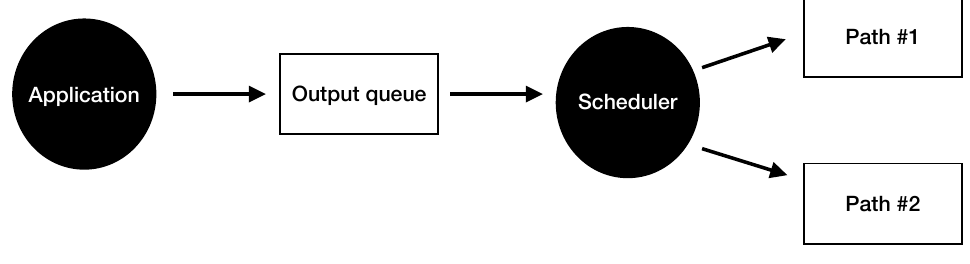
Figure 1. Simple